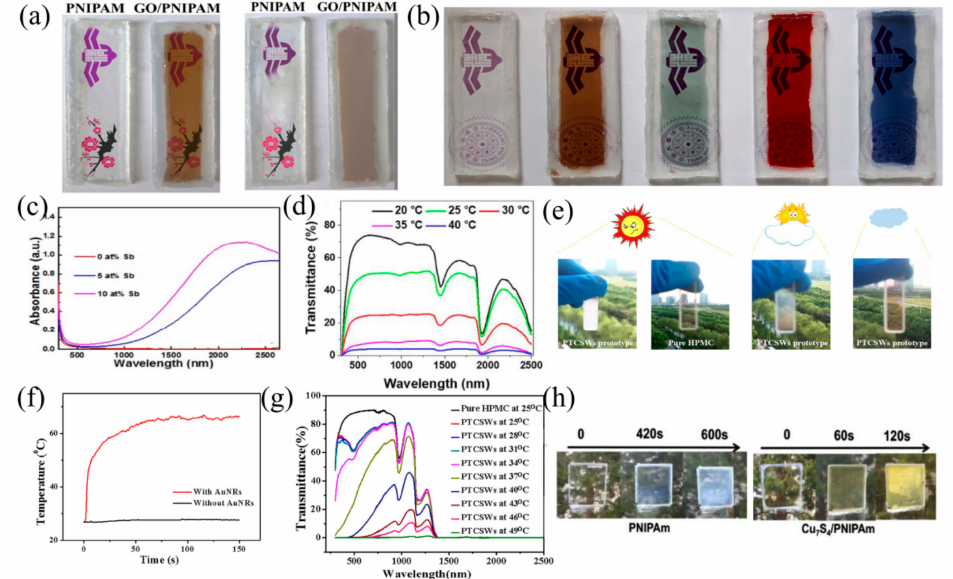
Figure 3. ( a ) Photos of the transparency/opacity transition of PNIPAm glass and GO/PNIPAm glass before and after 5 min of sunlight. Reproduced with permission from [25]. Copyright 2017,